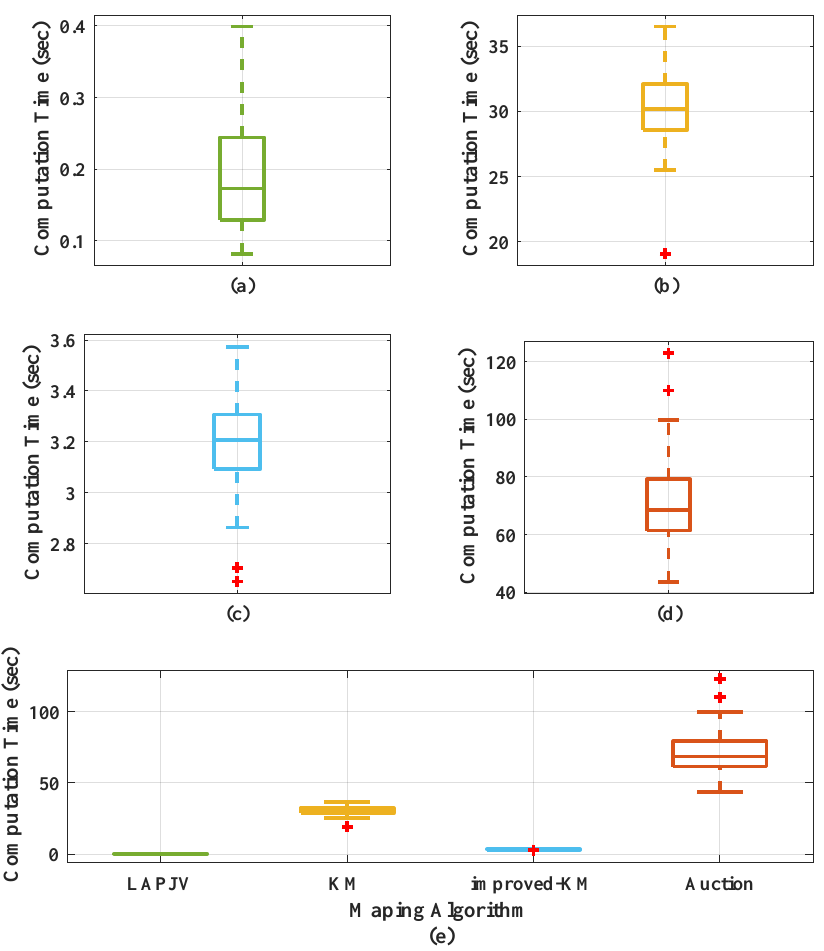
Figure 10. Computation time statistics of the four algorithms in the case of 1000 nodes. ( a ) Computa- tion time statistics for the LAPJV algorithm; ( b ) Computation time statistics for the KM algorithm; ( c ) Computation time statistics for the improved KM algorithm; ( d ) Computation time statistics for the Auction algorithm; ( e ) Computation time statistics comparison for the four algorithms in the same